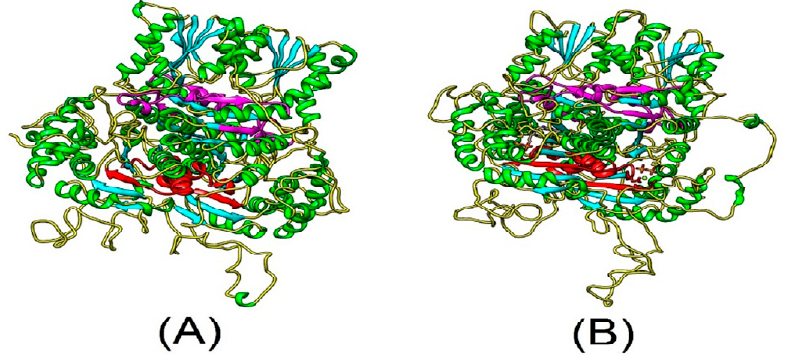
Figure 1. Predicted tertiary structures of AtDXS and PtDXS Green, cyan, and yellow, α -helices, β -strands, and random coils, respectively. Red and magenta, TPP and DRAG domain motifs, respectively. ( A ) Tertiary structure of AtDXS; ( B ) Tertiary structure of PtDXS.